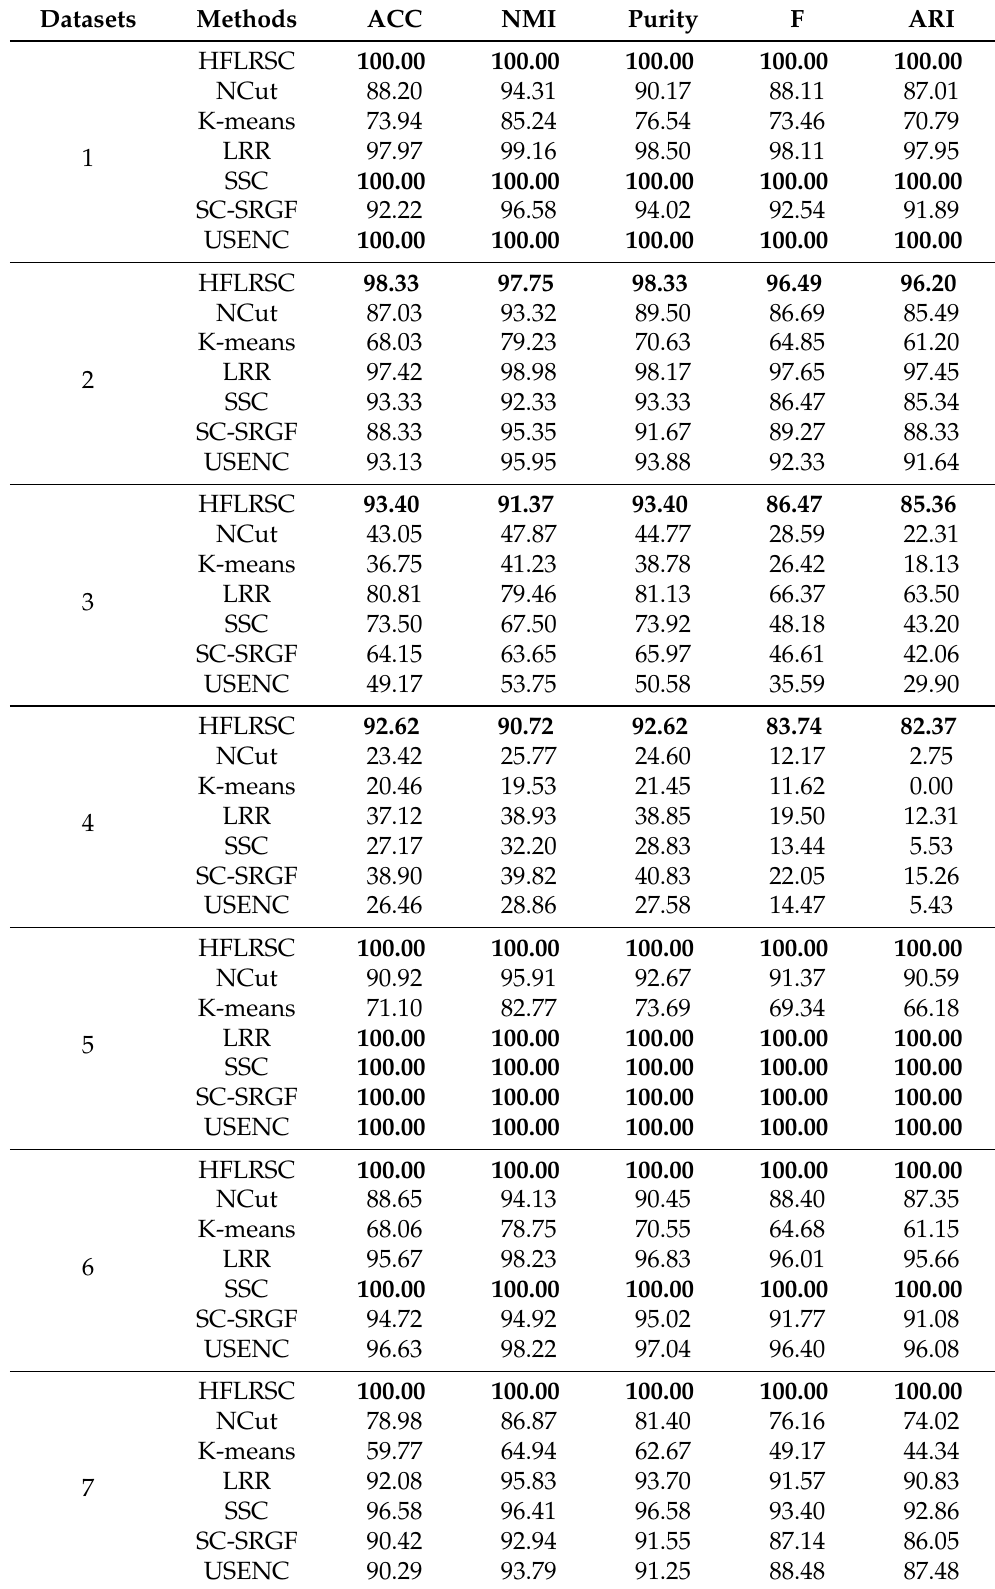
Table 2. The clustering performances of the proposed approach and the comparison methods for the simulated datasets (1–6). The bold denotes the best